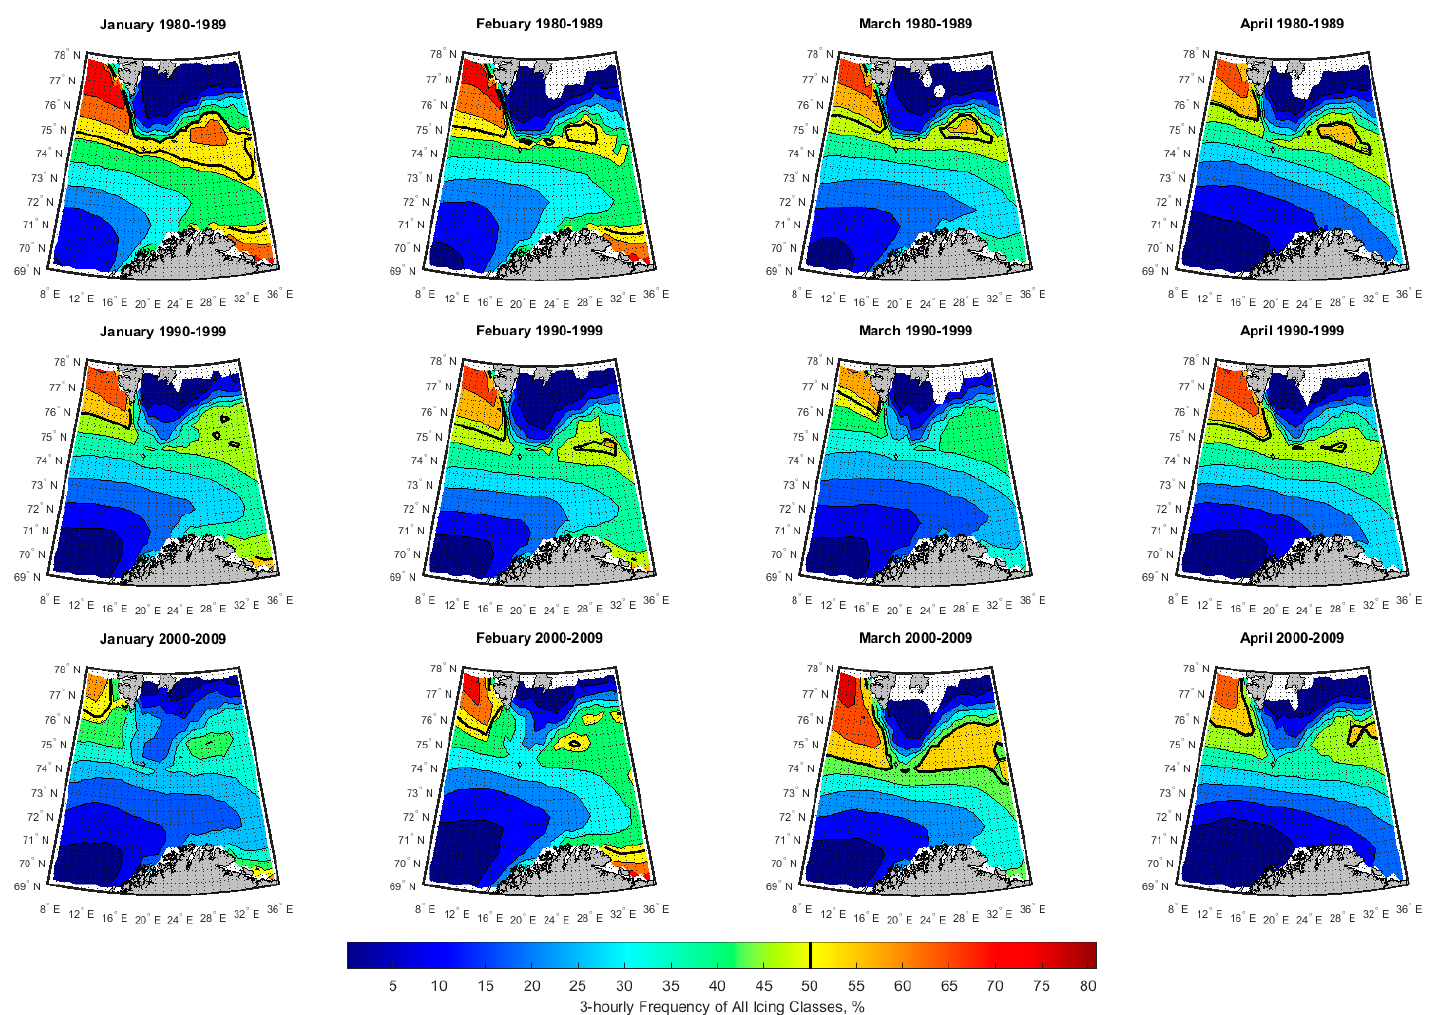
Figure 13. Three-hourly frequency of icing events (all classes) in each region during the 1980s, 1990s, and 2000s (Jan, Feb, Mar, Apr).